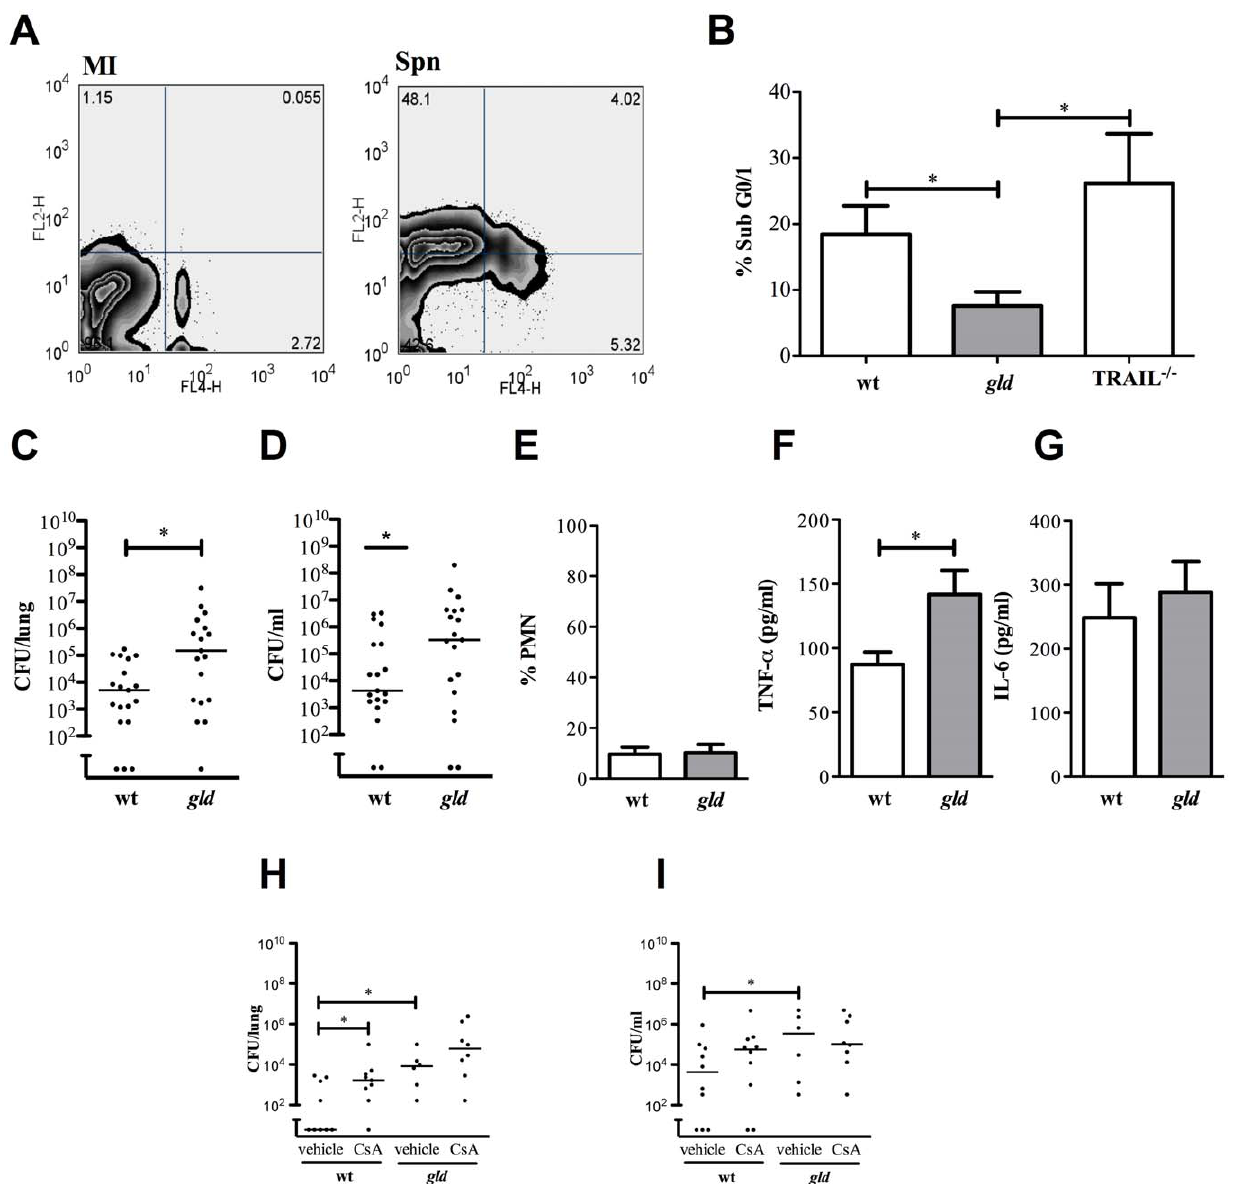
Figure 7. FasL regulates T-cell apoptosis and bacterial clearance in a murine model of invasive pneumococcal disease. A) Representative zebra plots measuring cell death in C57BL/6 mouse CD3 + T-cells isolated from spleens 24 h after mock-infection (MI) or intra-tracheal instillation with serotype 1 Streptococcus pneumoniae (Spn) (1 6 107 cfu). The zebra plots show Annexin V + (FL2-H) and TO-PRO-3 + (FL4-H) staining and the percentage of cells in each quadrant. B) The percentage CD3 + T-cells with accumulation of hypodiploid DNA (% Sub G0/1) isolated from spleens of mice 24 h after instillation of serotype 4 S. pneumoniae (1 6 107 cfu) to C57BL/6 wild-type (wt), generalized lymphoproliferative disease (gld) and TNF-related apoptosis inducing ligand deficient (TRAIL 2 / 2 ) mice. n=5, * p , 0.05; statistical analysis by t-test. C) Colony forming units (CFU) of bacteria in lung homogenates from wt and gld mice 24 h after intra-tracheal instillation of 5 6 105 CFU serotype 4 pneumococci and D) CFU of bacteria in blood. E) Percentage of neutrophils (%PMN) in bronchial alveolar lavage in the same experiments as C) and F) levels of TNF- a and G) IL-6 in bronchoalveolar lavage fluid, n=6. H) CFU of bacteria in lung homogenates from wt and gld mice 24 h after intra-tracheal instillation of 5 6 105 CFU serotype 4 pneumococci after treatment with cyclosporine A (CsA). I) CFU of bacteria in blood in the same experiments as H). Statistical analysis by t- test or Kruskal-Wallis test with Dunn’s Multiple Comparison Test, * p , 0.05.